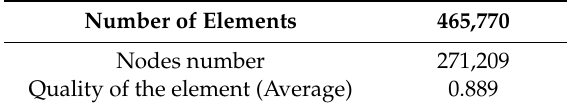
Table 6. Statistics of the mesh generated for the mechanical